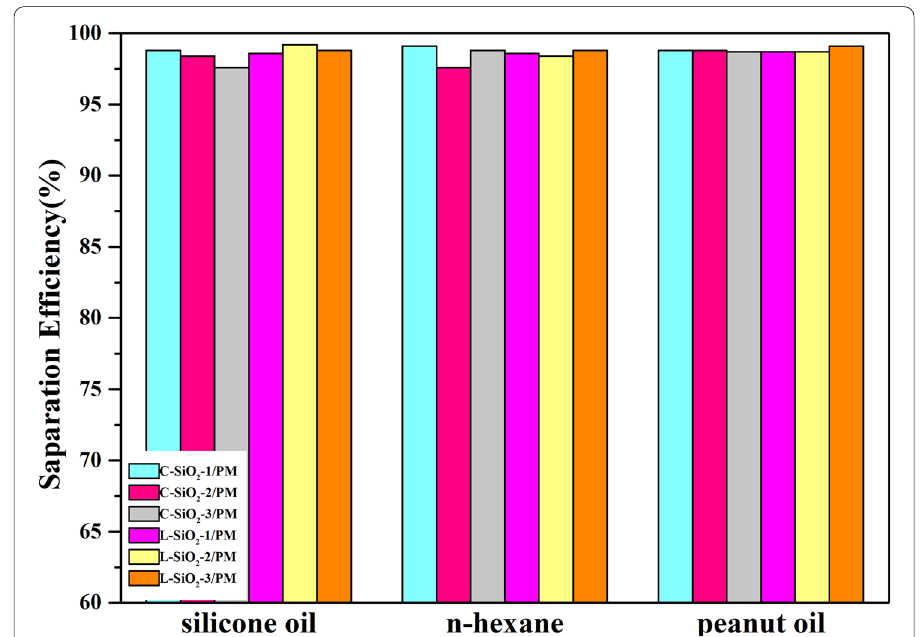
Fig. 9 Oil/water separation efficiencies of different